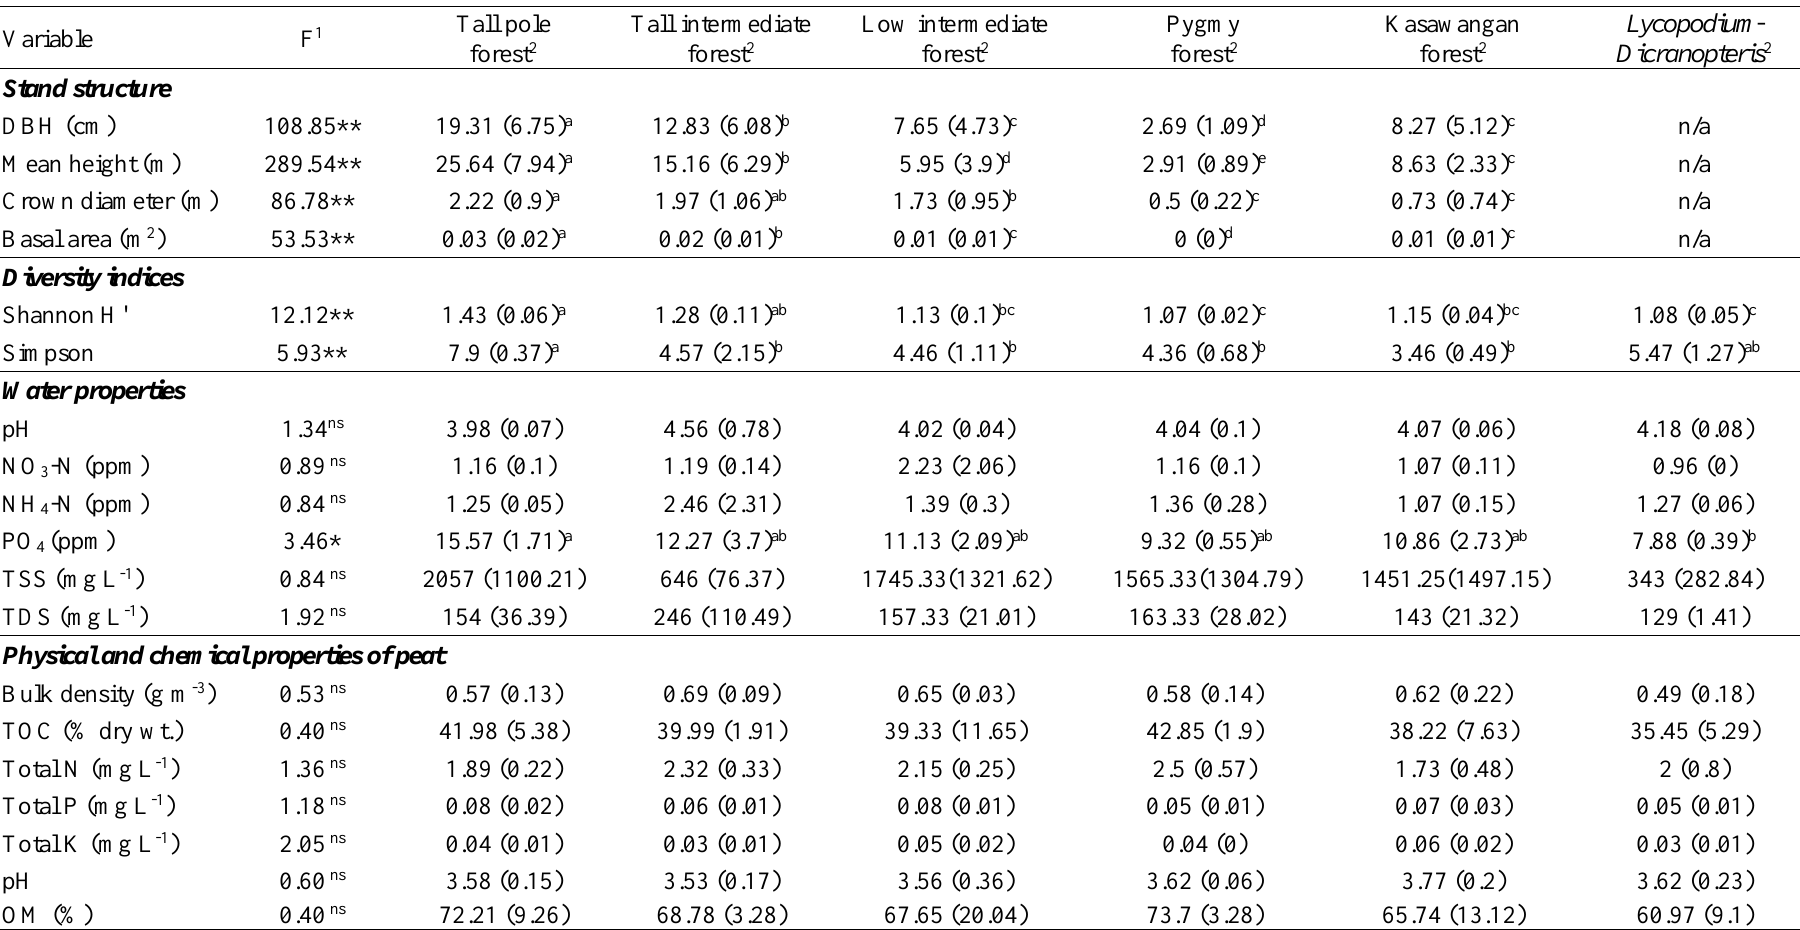
Table A1. Analysis of variance (ANOVA) on the stand structure (DBH = diameter at breast height), diversity index, water properties (TSS = total suspended solids; TDS = total dissolved solids) and peat physical and chemical properties (TOC = total organic carbon; OM = organic matter) of the six forest subtypes distinguished in the Caimpugan peat swamp